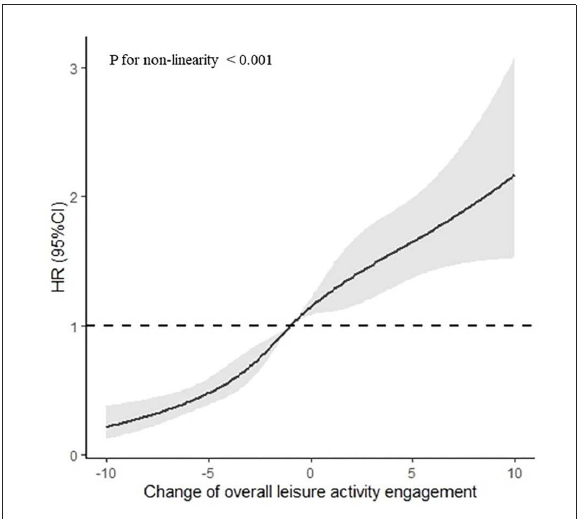
FIGURE2 Association between the LAE change points and MCI reversion rate based on restricted cubic spline model. The results derived from the full-adjusted models were presented as hazard ratios with 95% confidential intervals. The model adjusted for sex, age, residence, years of schooling, marital status, economic status, living pattern, number of people living with, smoking, alcohol drinking, activity of daily living (ADL), instrumental activity of daily living (IADL), and chronic disease (such as hypertension, diabetes, heart disease, stroke or CVD, cataract, digestive system diseases, arthritis, and Parkinson’s disease).